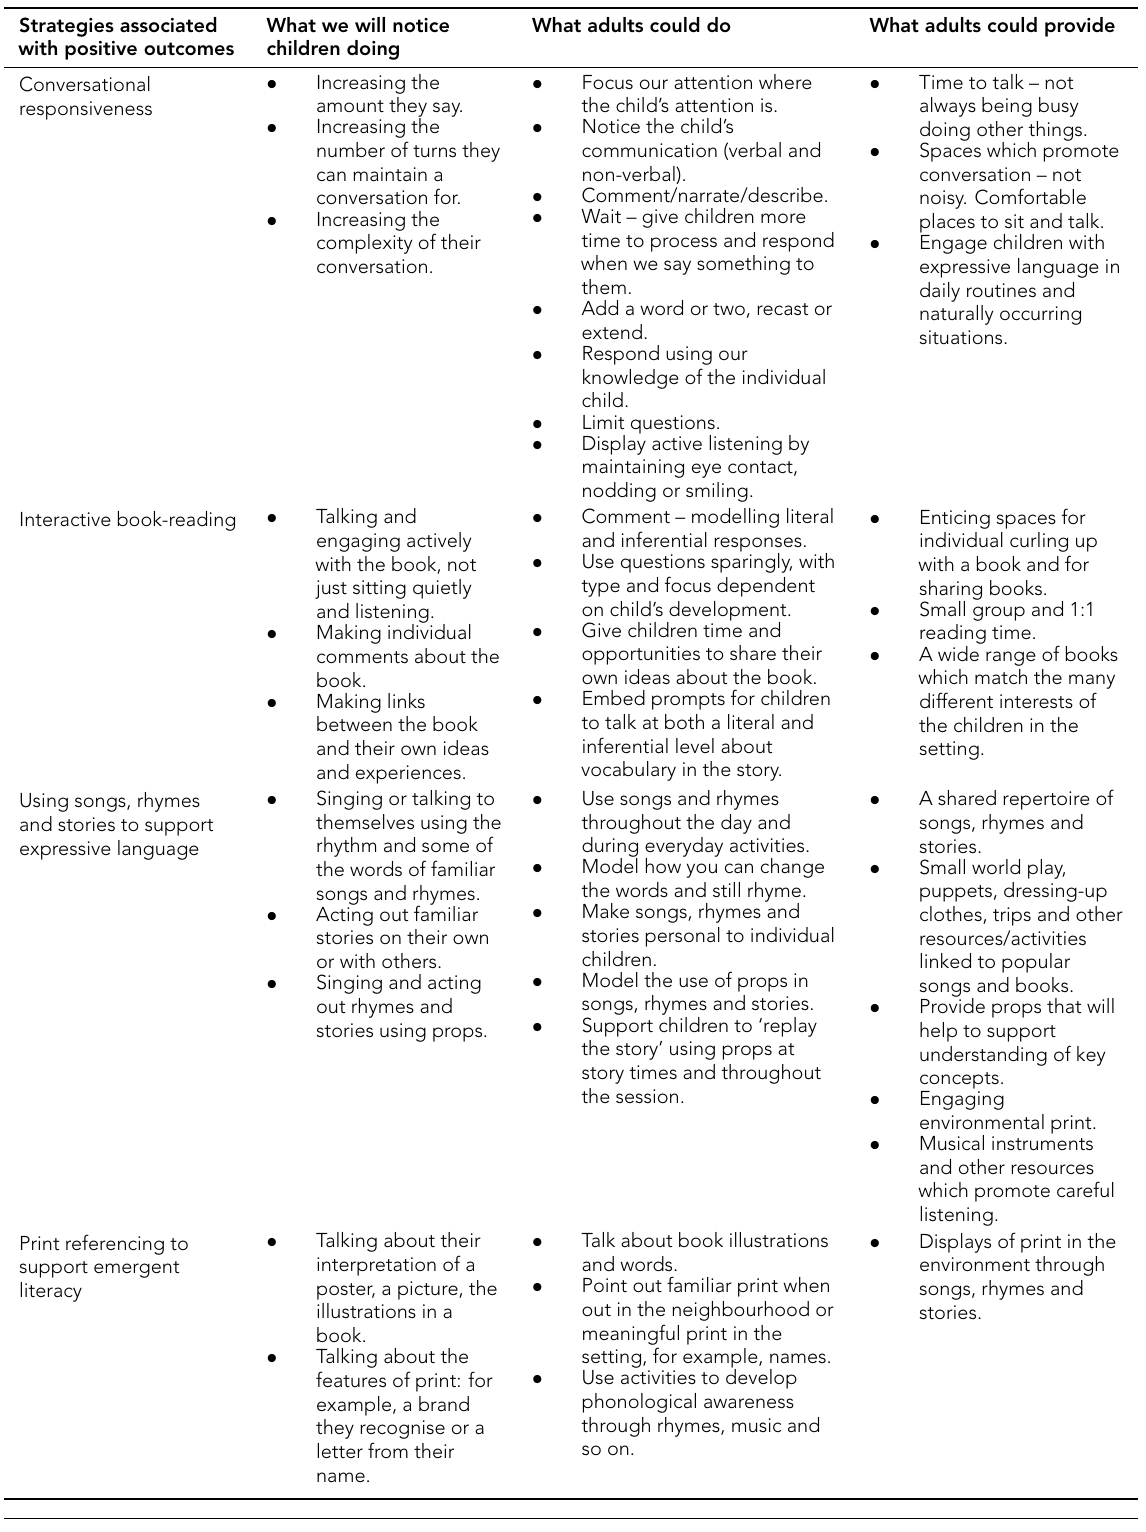
Table 1. Contents of Poster 1 (Source: authors) Strategies associated with positive